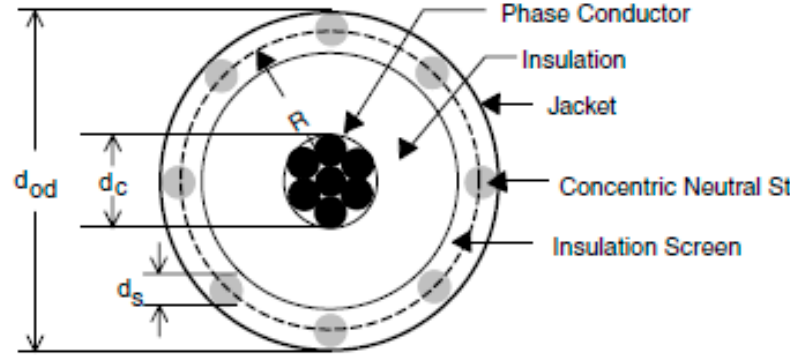
Figure A1. Concentric neutral cable cross-sectional diagram.